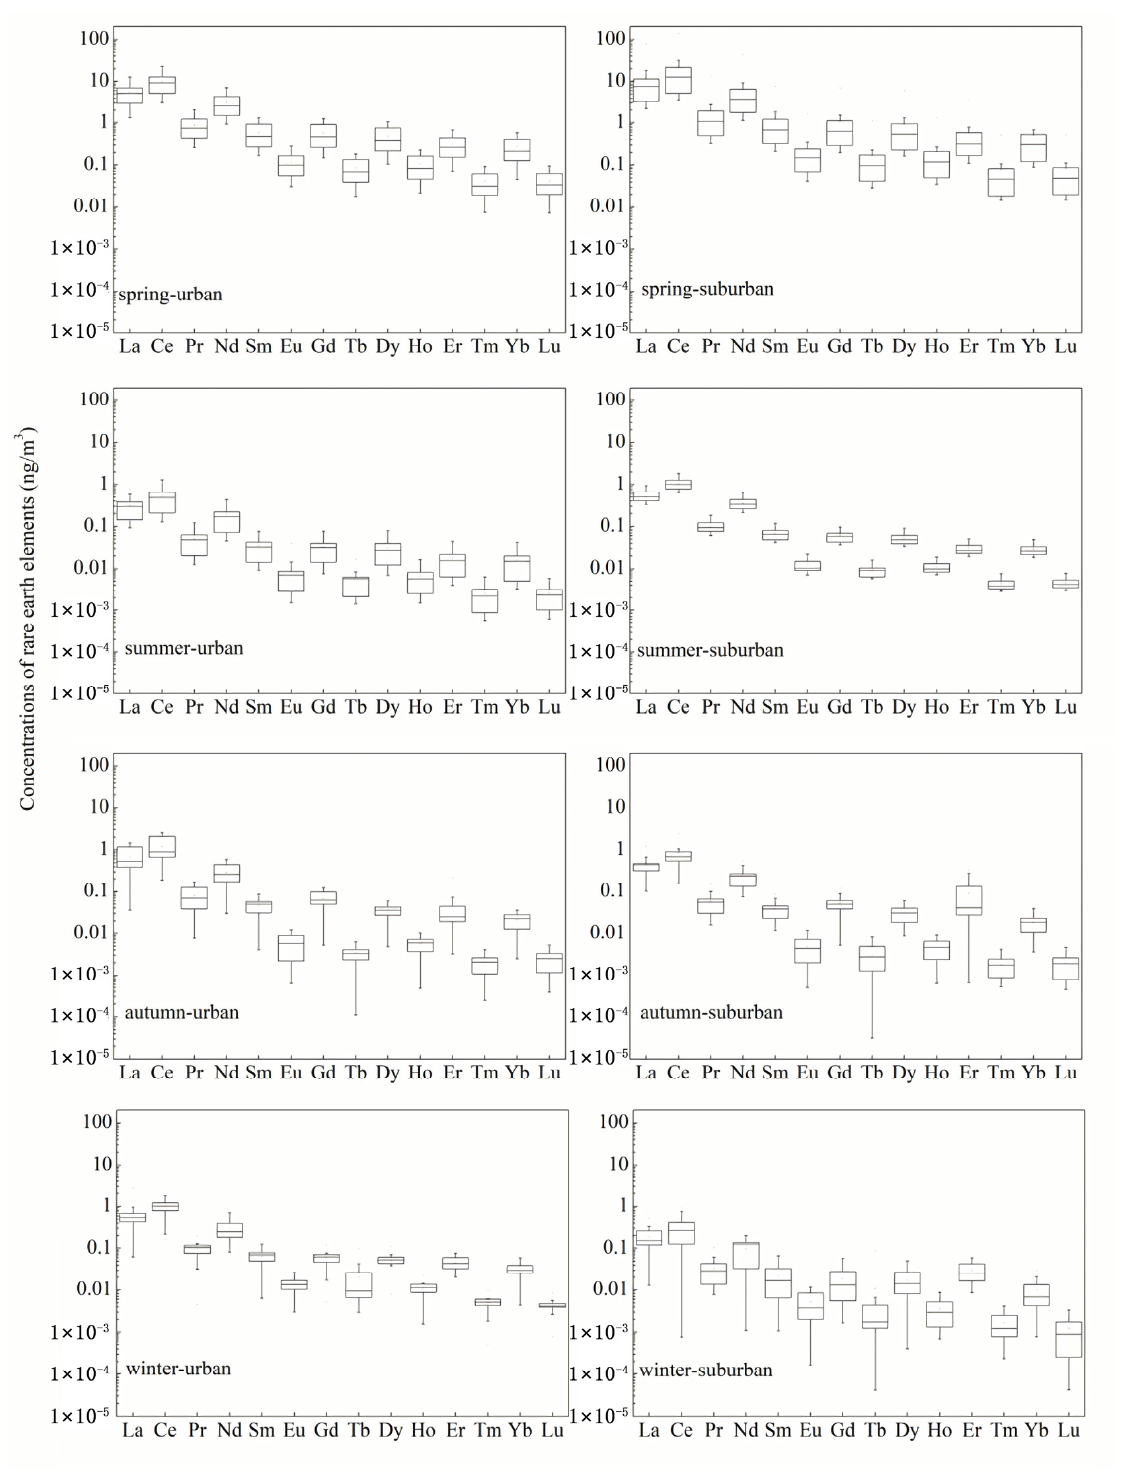
Figure 1. The concentrations of REEs in PM 2.5 in Xiamen.